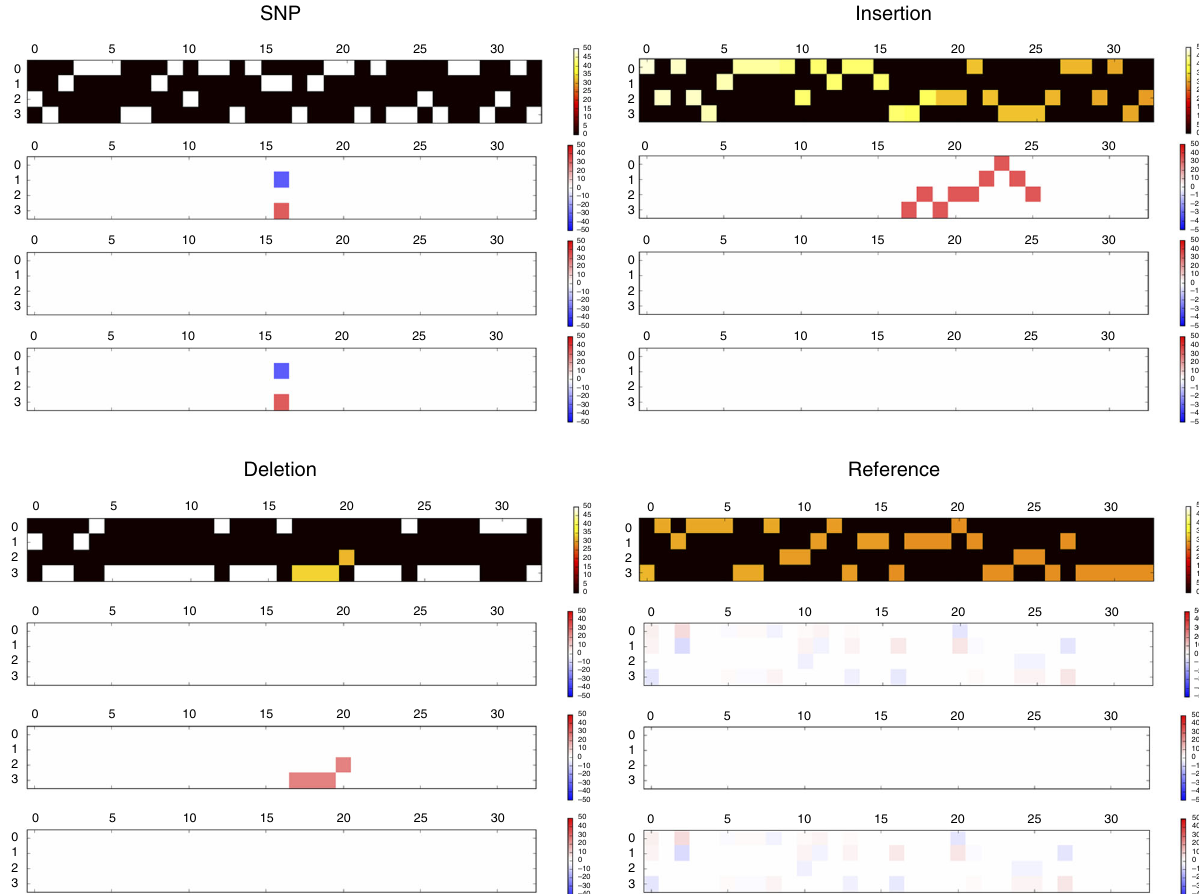
Fig. 4 Selected illustrations of how Clairvoyante represents the three common types of a small variant, and a nonvariant. The fi gure includes: (top left) a C > G SNP, (top right) a 9-bp insertion, (bottom left) a 4-bp deletion, and (bottom right) a nonvariant with a reference allele. The color intensity represents the strength of a certain variant signal. The SNP insertion and deletion examples are ideal with almost zero-background noise. The nonvariant